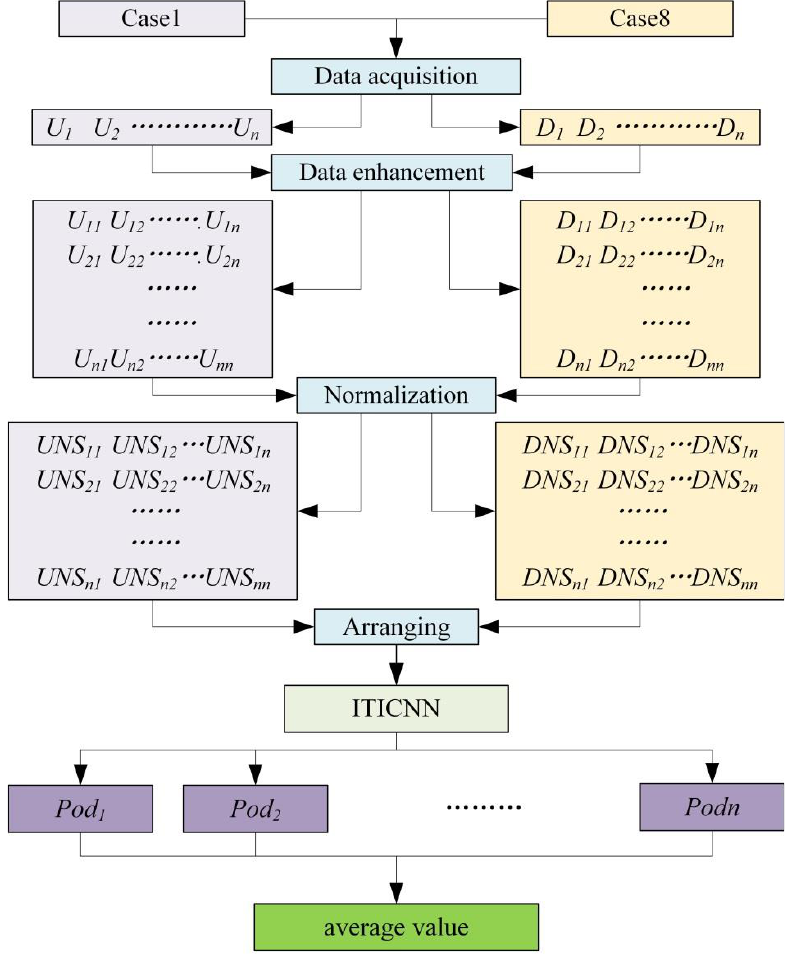
Figure 2. Fault diagnosis